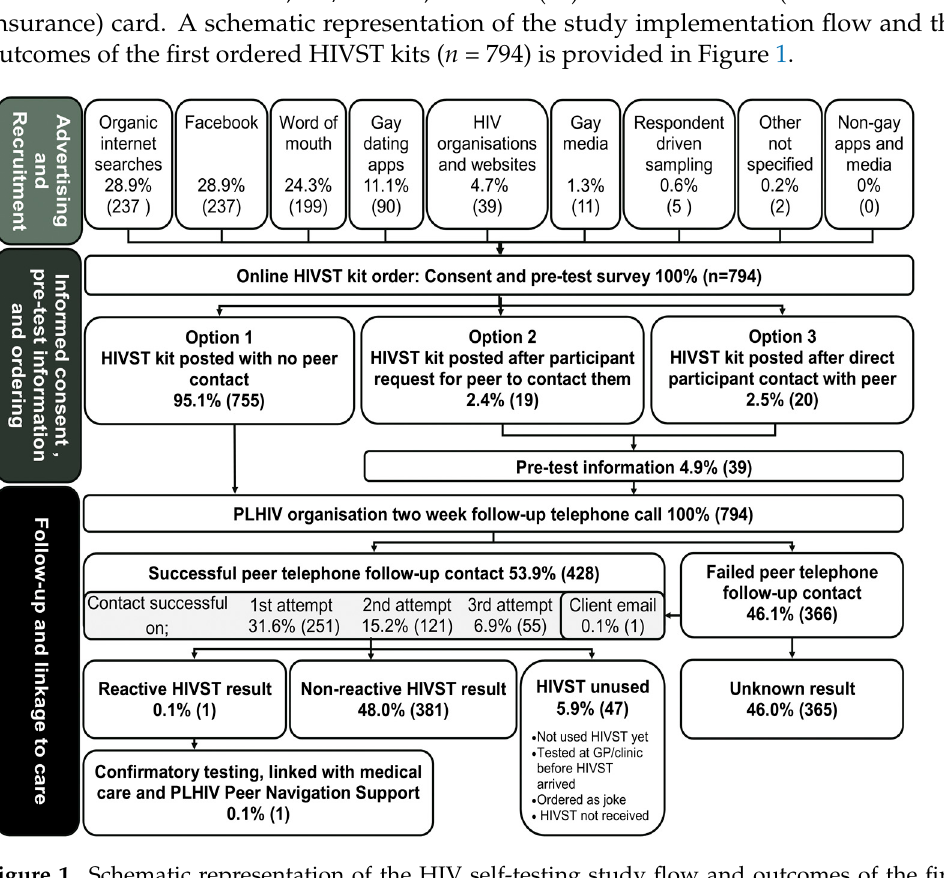
Figure 2. Percentages of first and repeat orders of HIVST kits ordered, by study quarter (SQ).